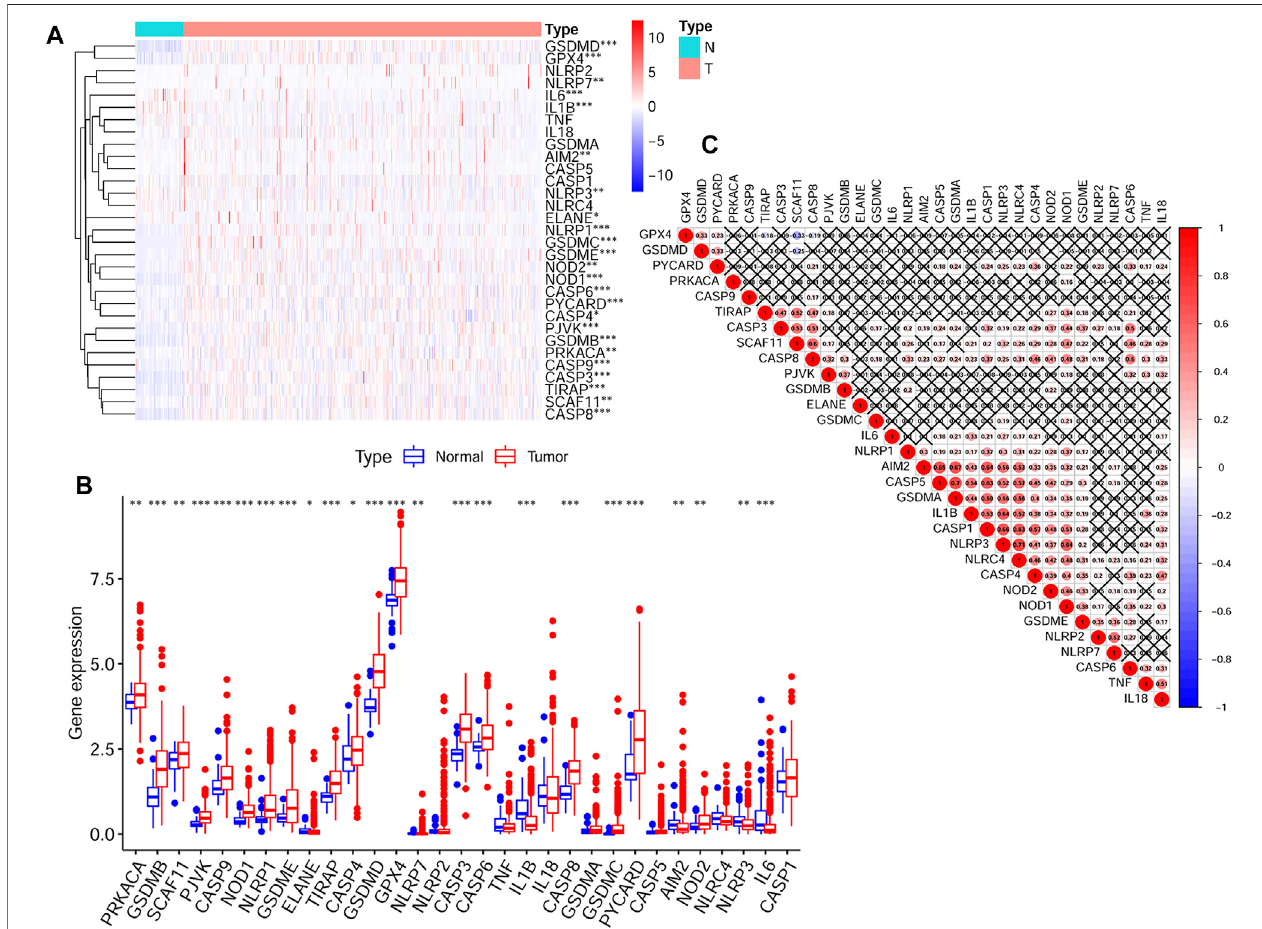
FIGURE 1 | The transcription levels of 31 pyroptosis-related genes and the interactions among them (A) The transcription levels of 31 pyroptosis-related genes betweentumor andnormal tissueswereshown inaheatmap (B) Thetranscription levels of31pyroptosis-relatedgenesbetweentumorand normaltissueswereshown in a box plot (C) The correlations between the pyroptosis-related genes ( p values were represented as: ns not signi fi cant; * p < 0.05; ** p < 0.01; *** p < 0.001.).